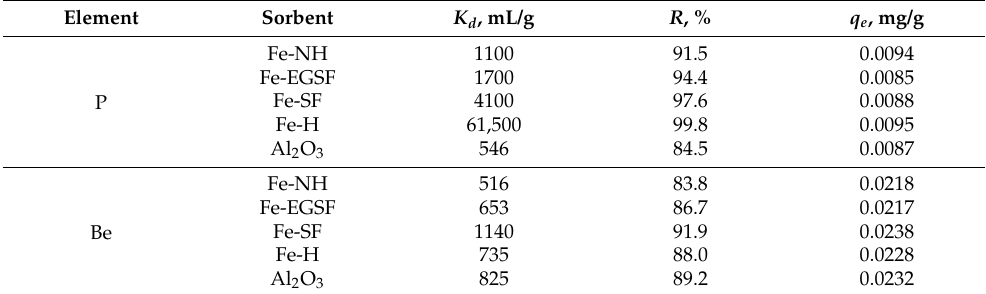
Table 3. Sorption parameters of phosphorus and beryllium under static conditions.